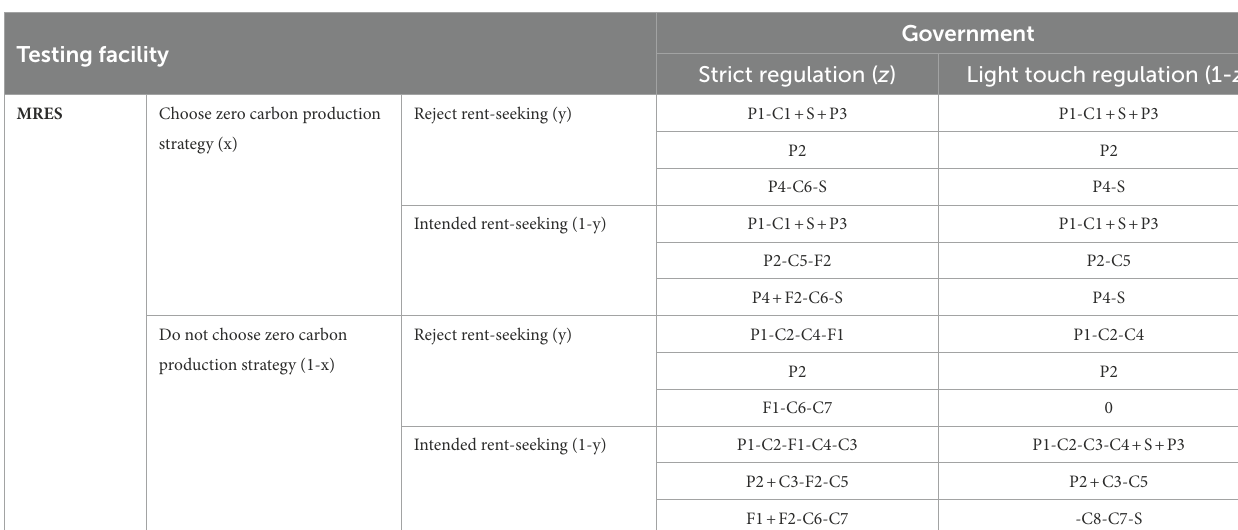
TABLE 2 The tripartite game’s benefit matrix and model